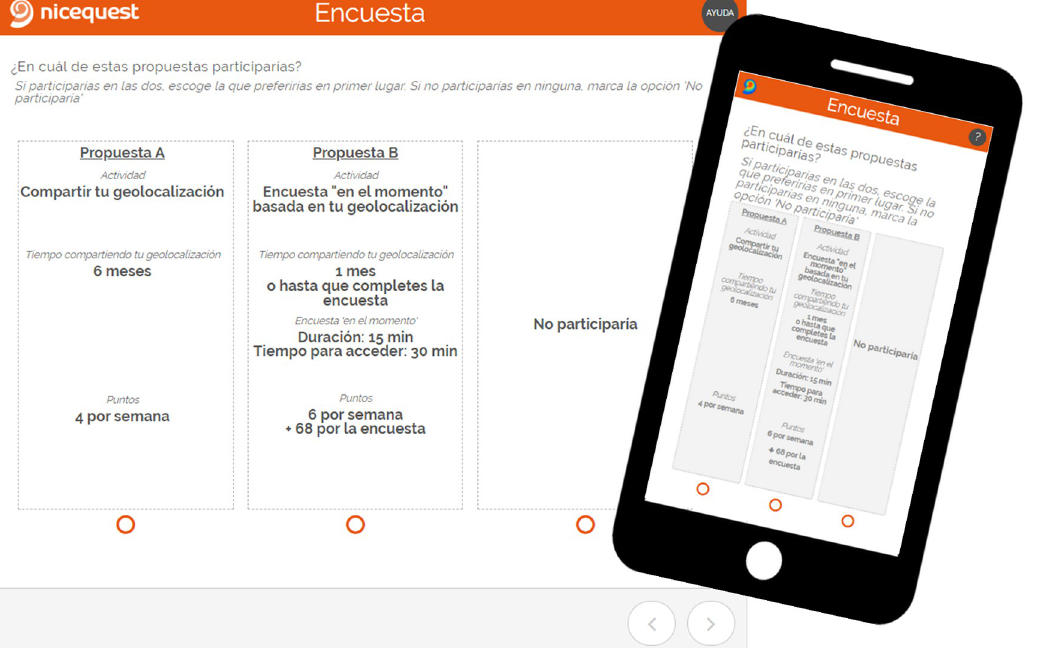
Fig 1. Example of a conjoint question (PC and smartphone